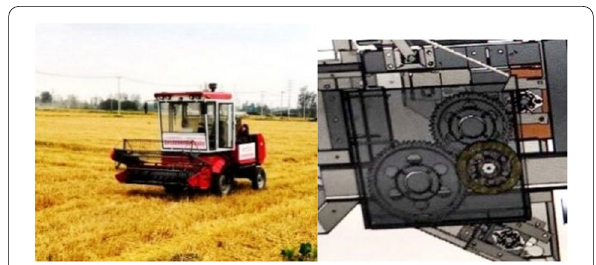
Figure 1 Self-propelled straw baler and its